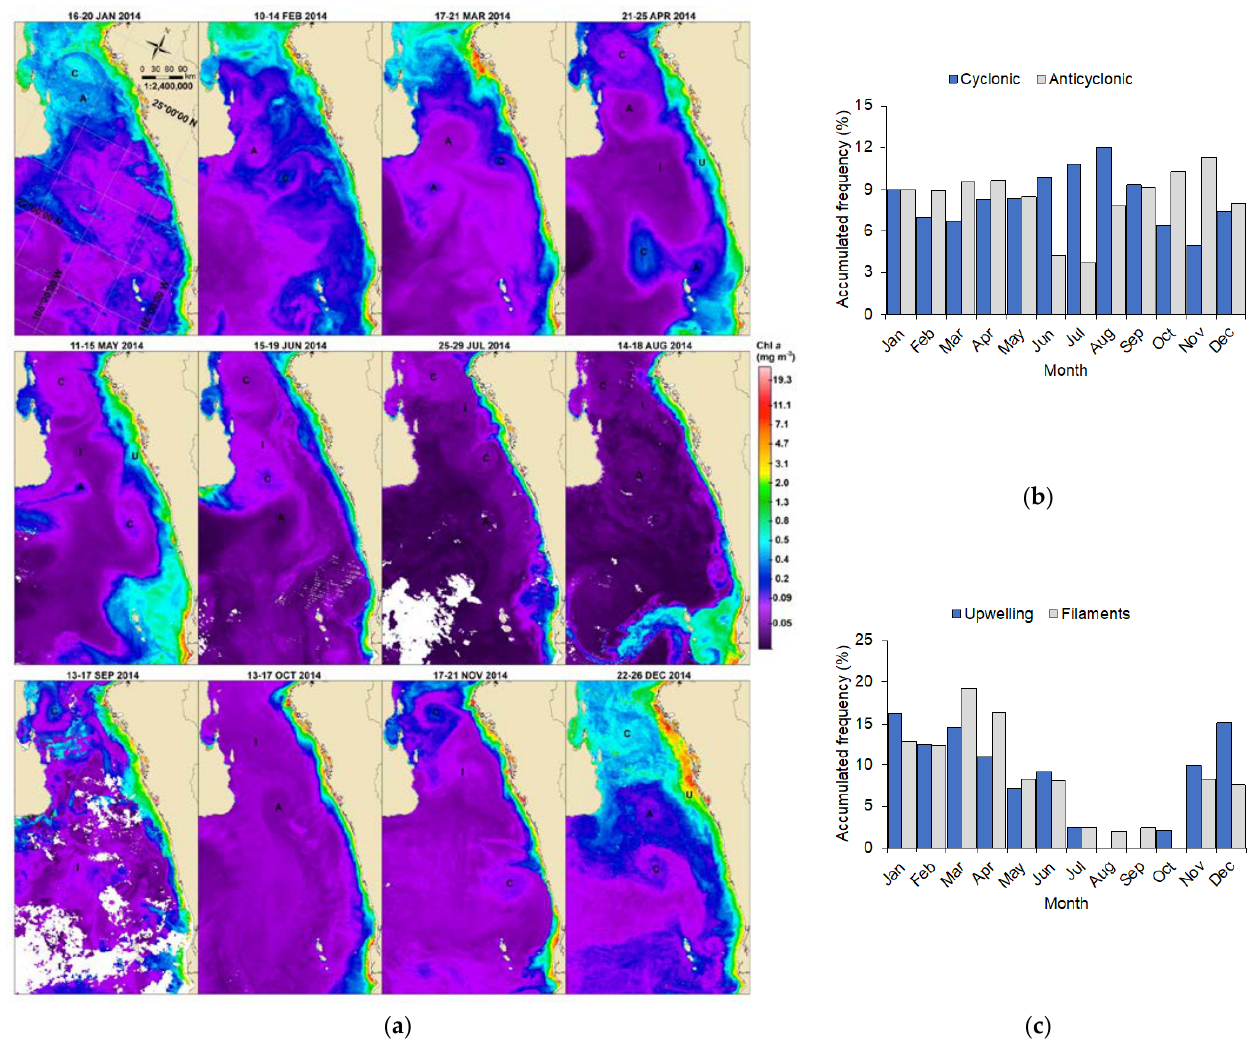
Figure 6. Annual frequency of mesoscale events in the Southern Gulf of California. ( a ) Satellite images of chlorophyll a concentration (mg m −3 ) characterizing a typical year (2014) for anticyclonic eddies (A), cyclonic eddies (C), coastal upwelling (U), filament (F); Percentage of the accumulated annual frequency of ( b ) cyclonic and anticyclonic eddies; ( c ) coastal upwelling and filaments.